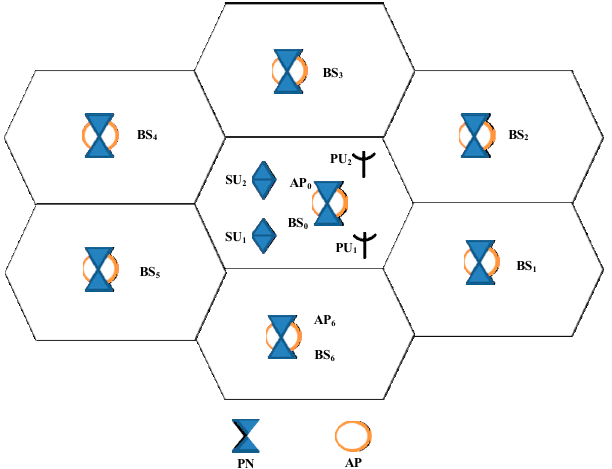
Figure 1. The Model of cellular cognitive radio networks (CCRN).